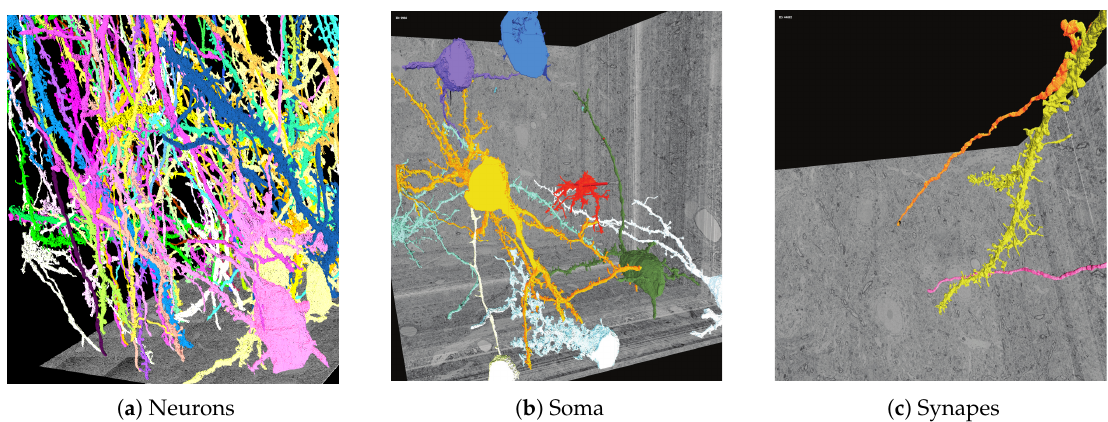
Figure 8. Three-dimensional polygonal mesh reconstructions of automatically-labeled connectomics data using our Web-based 3DXP software (downsampled to 3 k × 3 k × 1.6 k voxels). Since the reconstructions are hundreds of megabytes in size, we stream and render the geometries progressively. The displayed scenes show: ( a ) twenty neurons stretching through a 100 µ m 3 volume; ( b ) multiple cell bodies (soma) visualized; ( c ) a dendrite with two synaptic connections. All scenes are interactive with zoom, pan, and scroll interactions. It is also possible to mouse click on a mesh region to open other visualizers for further data exploration, e.g., in